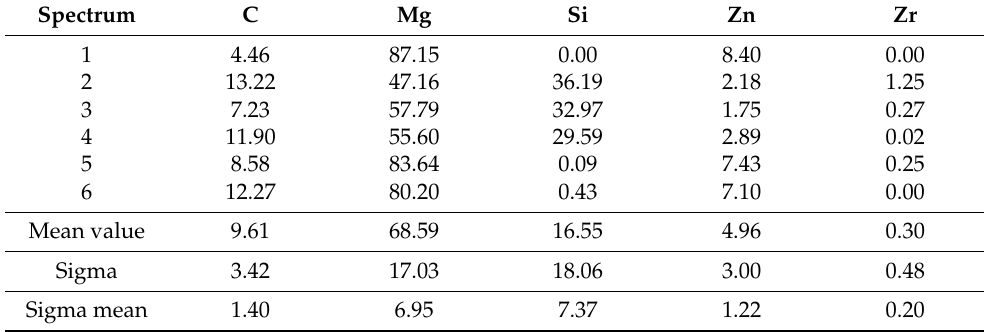
Table 3. The spectral analysis results of the regions in Figure 3a for ZK60 + 15% SiC.